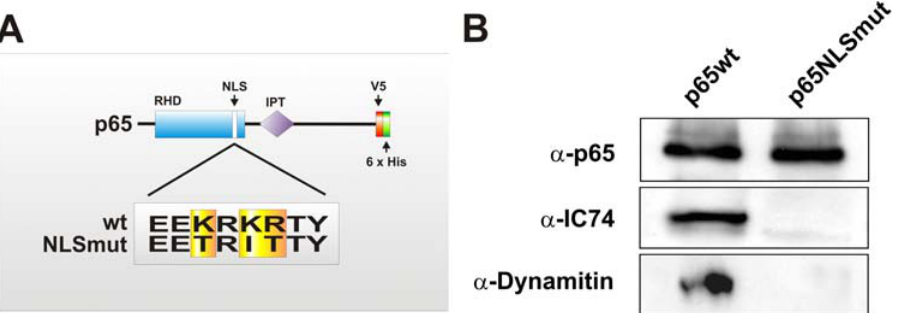
Figure 2. The functional nuclear localization signal (NLS) of p65 is essential for its interaction with dynein/dynactin invitro. (A) Nuclear localization signal (NLS) of wild-type NF- k B p65 and its NLS mutant (NLSmut). The NLS of NF- k B p65 consists of a stretch of a basic amino acids, arginines and lysines. The three point mutations were introduced into the NLS (depicted in yellow). The construct was tagged with polyhistidine to enable purification from bacterial extracts and pull-down assays. (B) Polyhistidine-tagged wild-type p65 and p65 with mutant NLS (NLSmut) purified from bacterial extracts were immobilized separately on nickel-coated matrix and incubated with the rat brain extract. The bound material was eluted from the matrices, fractionated by SDS–PAGE and examined by Western blot with anti-IC74 and anti-dynactin p50 antibodies. As expected, wild-type p65 associates with dynein/dynactin in vitro. In contrast, p65 with mutant NLS failed to form this complex.